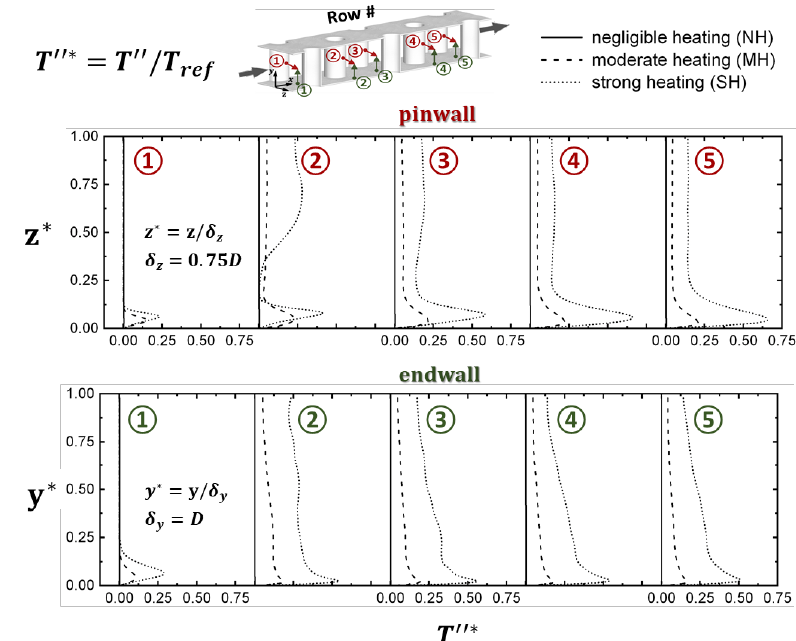
Figure 15. Temperature variance profiles for NH, MH, and SH wall heating.